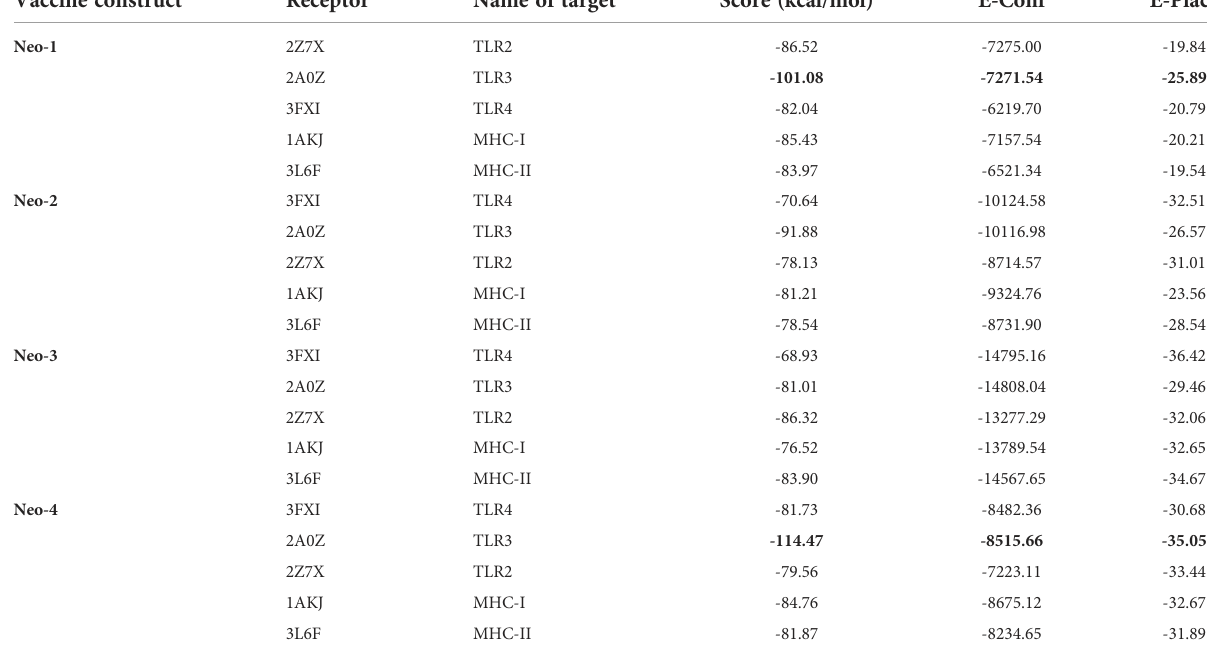
TABLE 7 Molecular docking results of Neo-1-4 with selected